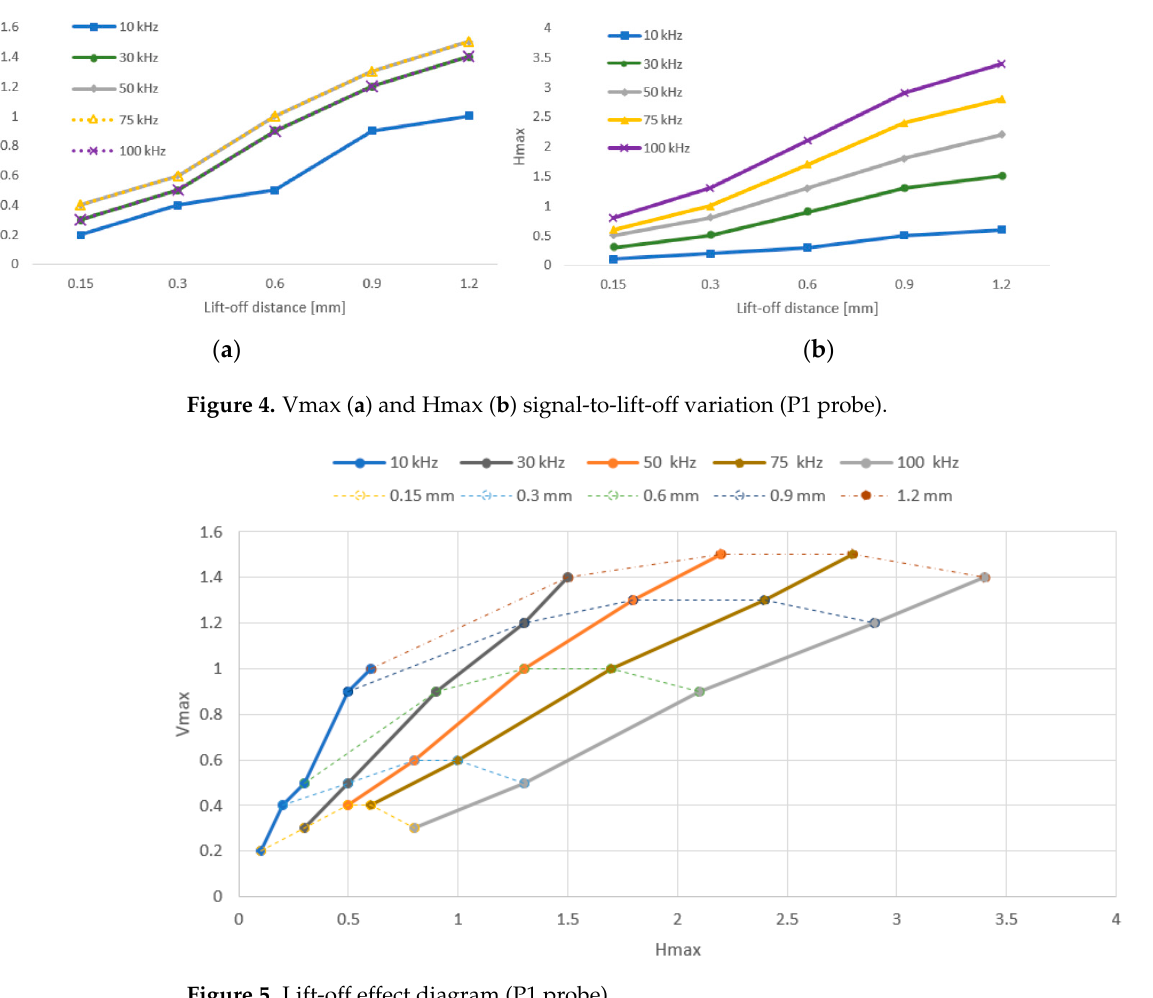
Figure 5. Lift-off effect diagram (P1 probe).